Question: According to the figure, is the described quantity increasing or decreasing?
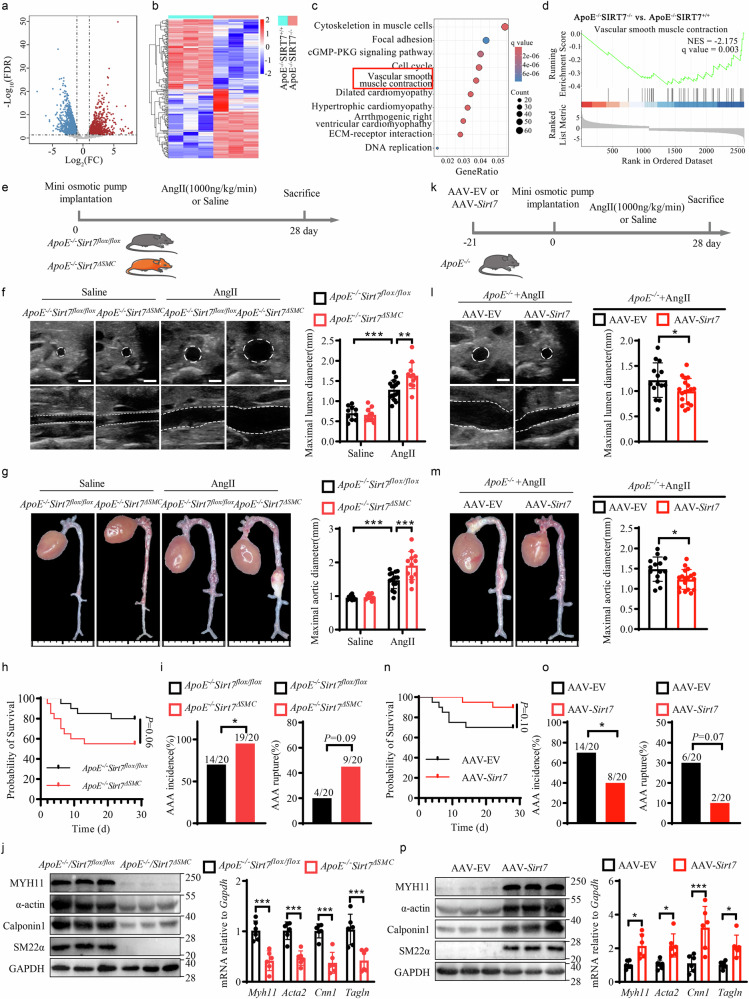
Answer: increasing